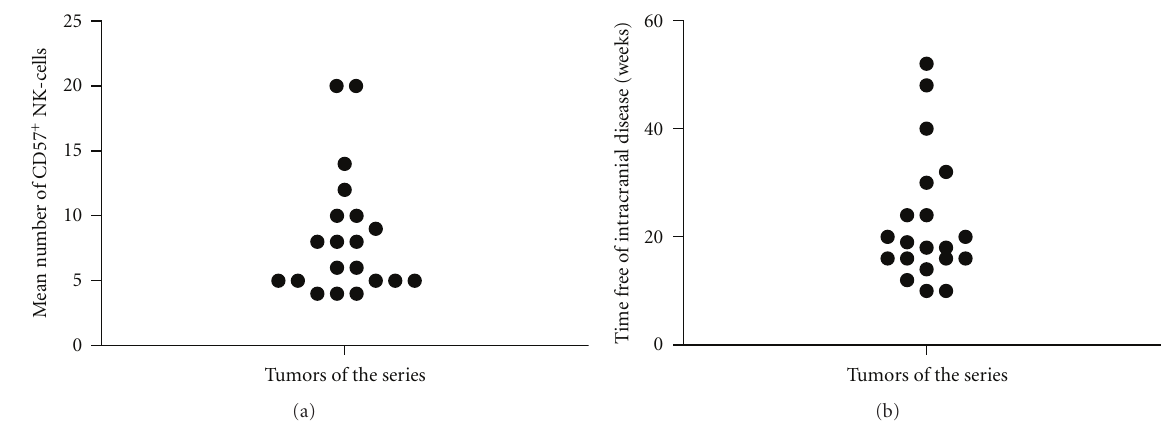
Figure 2: (a) Distribution of the mean values of CD57 + NK-cells by microscopical field, at 200x, in the tumors of the series. (b) Time free of local recurrence or new intracranial metastases, in the cases of the series.